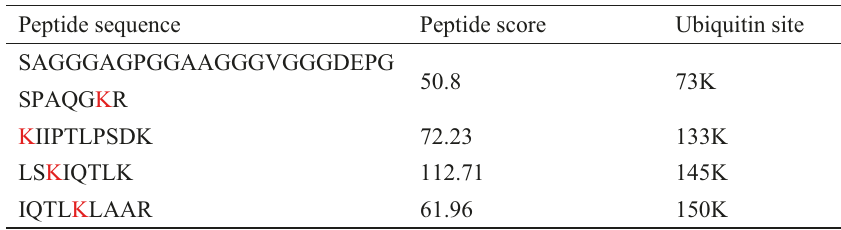
Table 1. List and site details of ubiquitinated peptides in TWIST1.